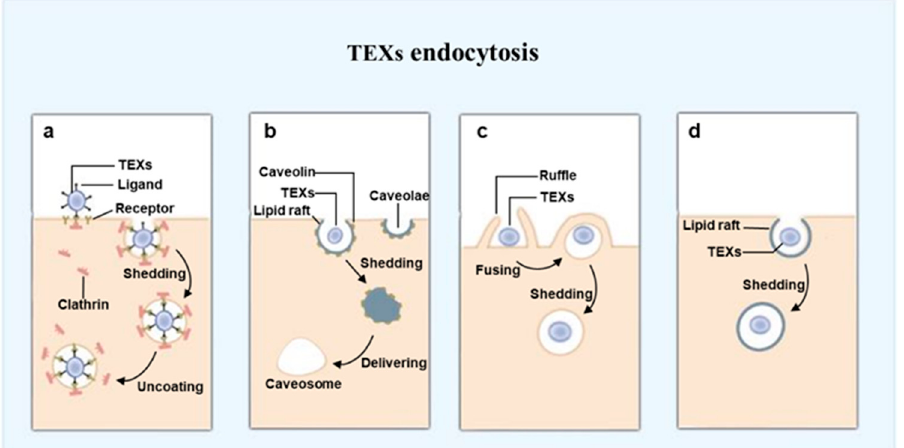
Figure 5. Forms of TEXs endocytosis. TEXs endocytosis can roughly be divided into four forms: clathrin-mediated endocytosis ( a ), caveolin-dependent endocytosis ( b ), micropinocytosis ( c ) and lipid raft-mediated endocytosis ( d ).